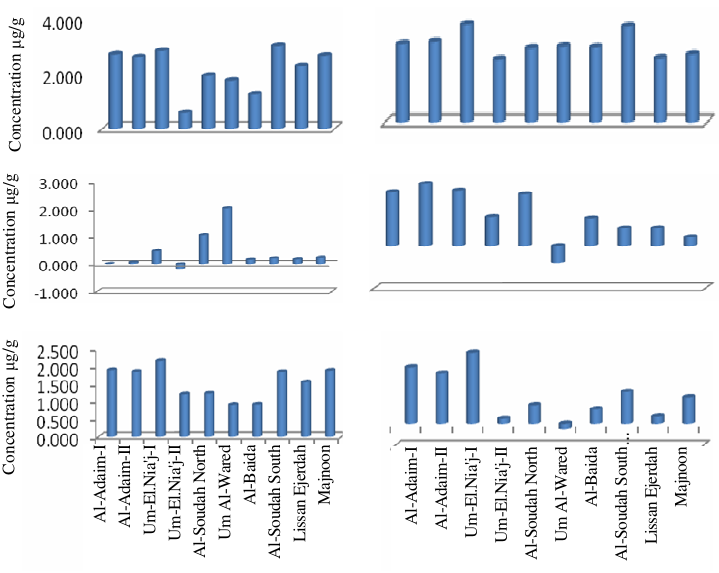
Figure 2 . The geochemical index of studied heavy metals in Al-Hawizeh Marsh during the study